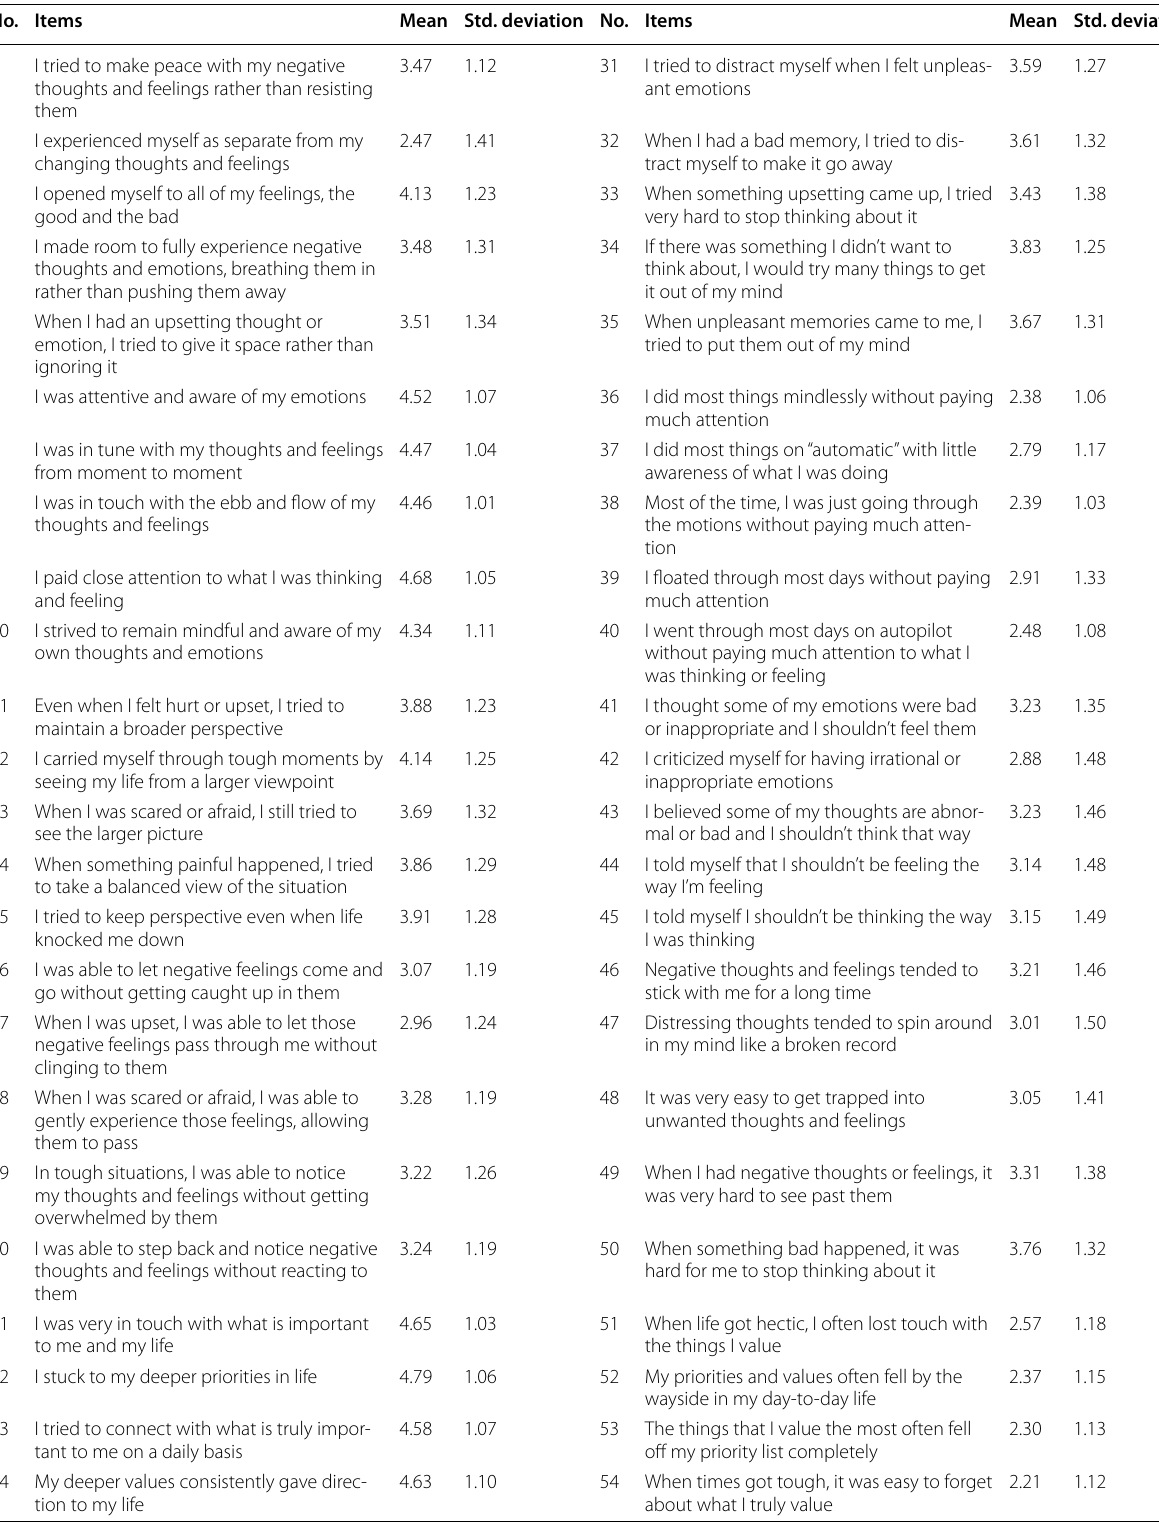
Table 2 Means and standard deviations of the items of psychology flexibility No. Items Mean Std. deviation No. Items Mean Std.